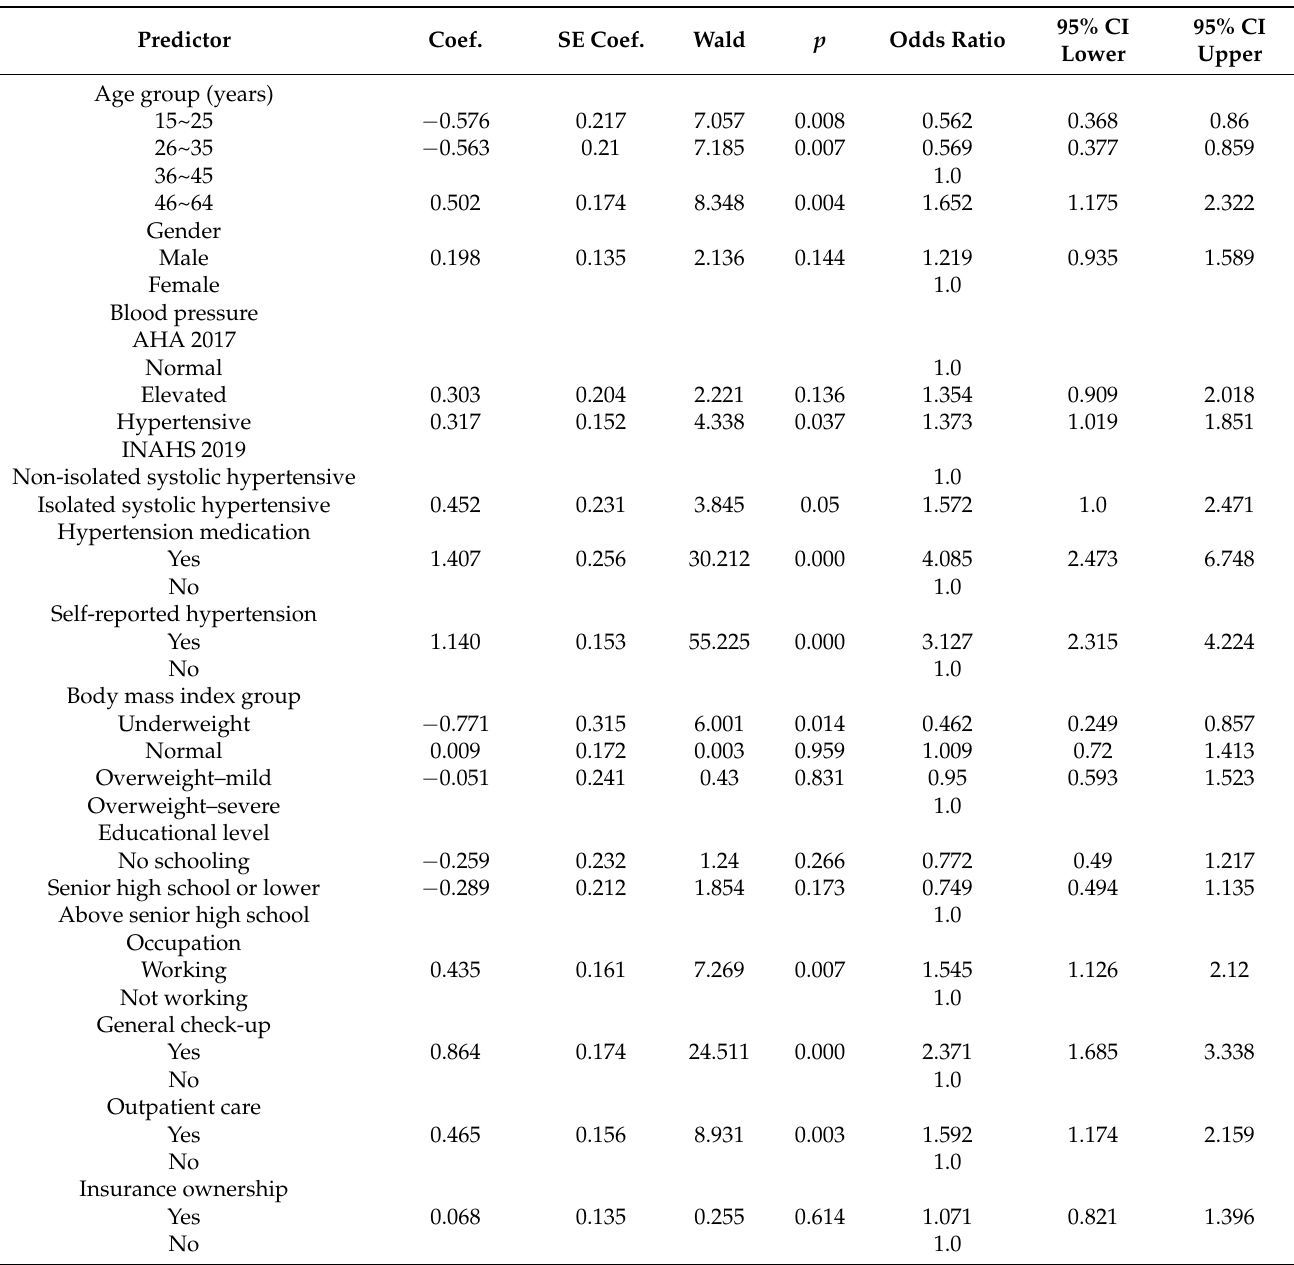
Table 2. Univariate logistic regression of hearing problems and demographic